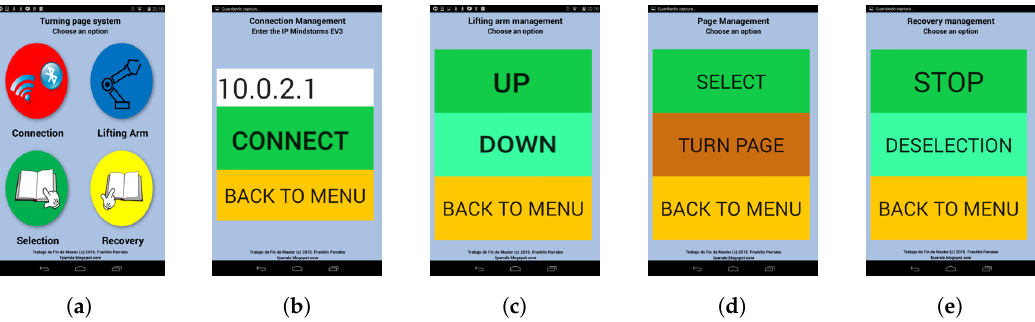
Figure 3. Screenshots of the user interface proposal. ( a ) Main menu; ( b ) Connection menu; ( c ) Lifting arm control; ( d ) Page selection options; ( e ) Recovery